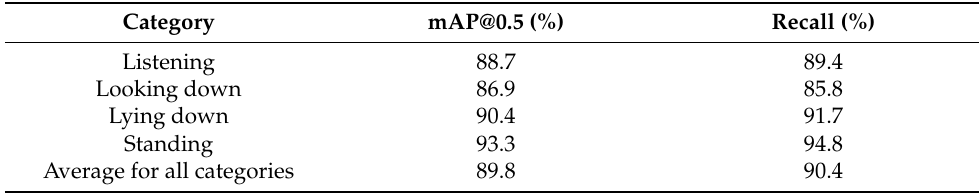
Table 2. Average precision and recall for each